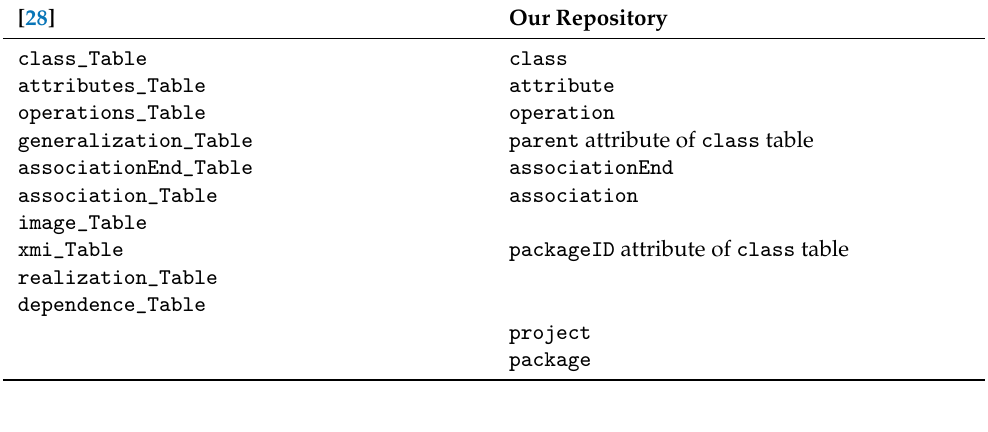
Table 4. Comparison with the schema of the metadata repository in [28].